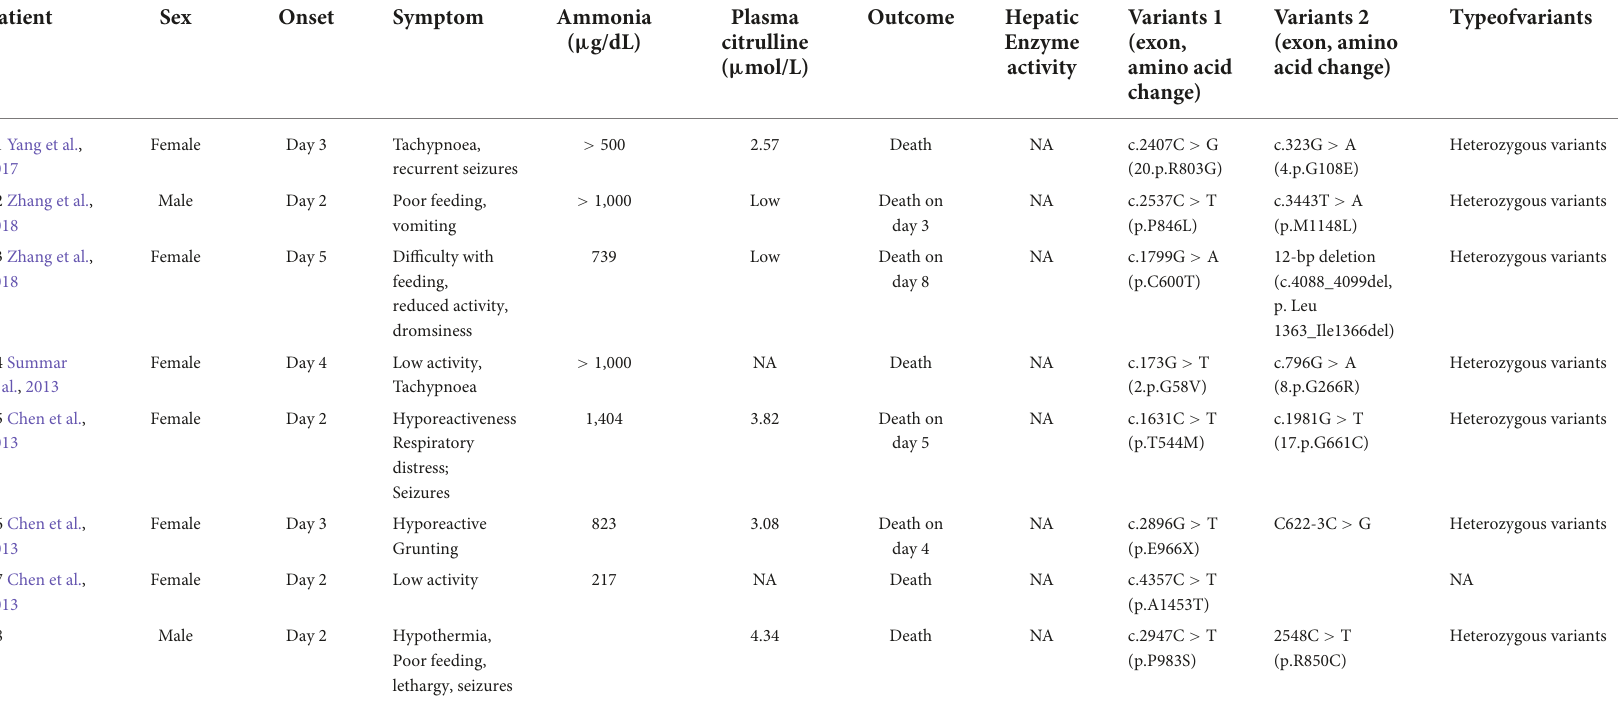
TABLE 1 Summary of the clinical characteristics and mutational analyses of carbamoyl phosphate synthetase 1 deficiency (CPS1D) in Chinese patients.